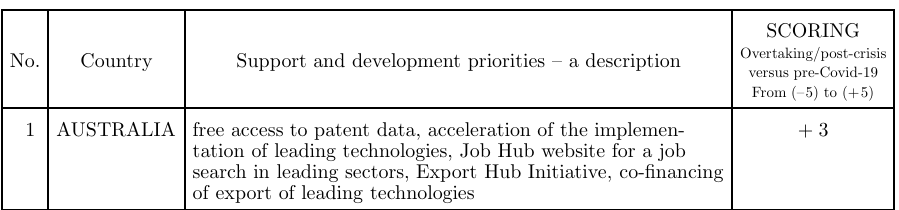
Coronavirus support combined with developmental priorities – examples